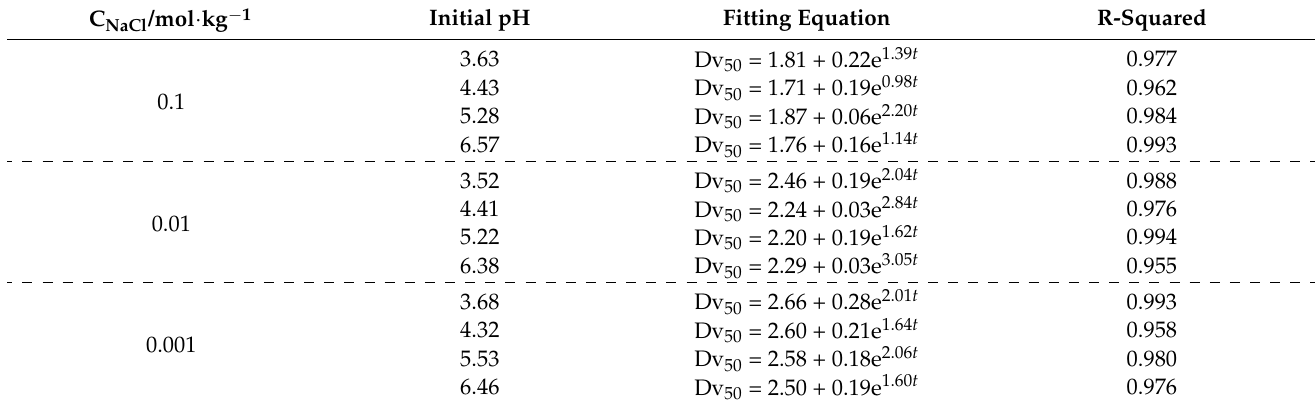
Table 3. Fitting equations of kinetic variations in Dv 50 of the IREO colloids with the change in aggregation time after NaCl concentration and pH value